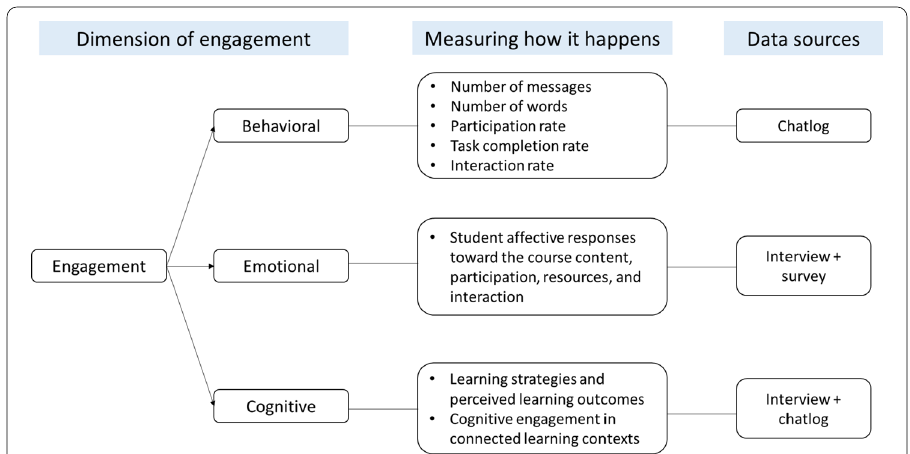
Fig. 4 The measurements and data sources of behavioral, emotional, and cognitive